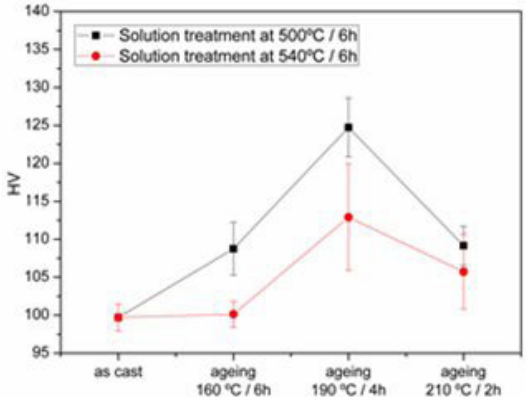
Figure 8. Results of microhardness obtained in the samples without and with heat